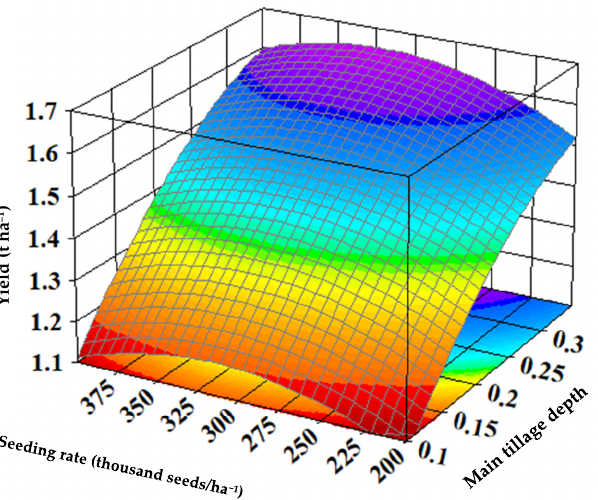
Figure 3. Response surface graph for the dependence of the yield of Zavolzhsky safflower cultivar on seeding rate and tillage treatment.